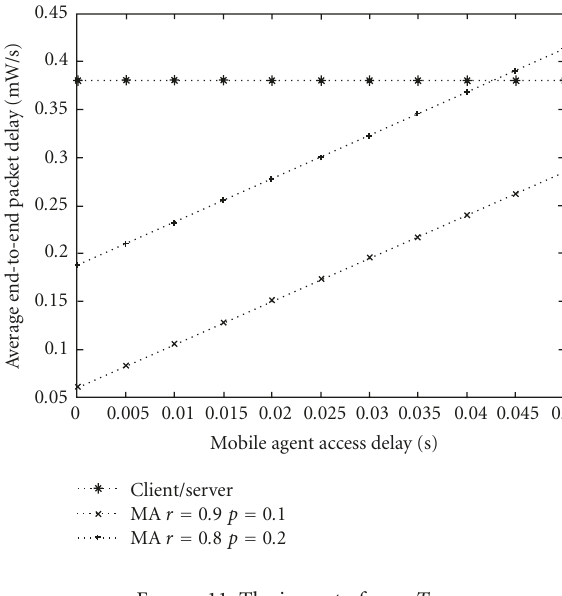
Figure 10: The impact of T task on e .